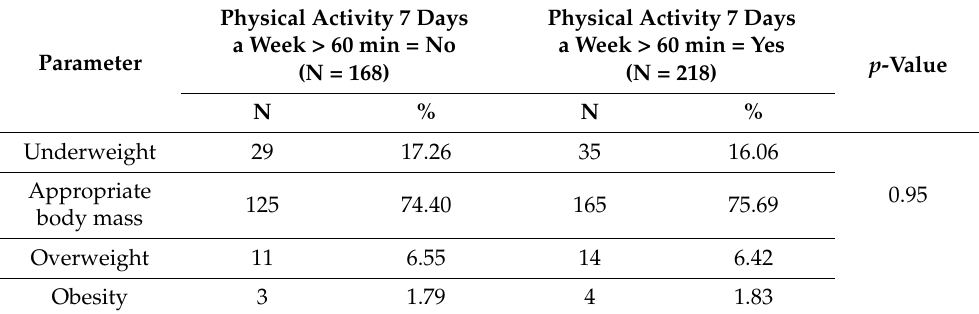
Table 6. The relationship between the appropriate level of physical activity and the